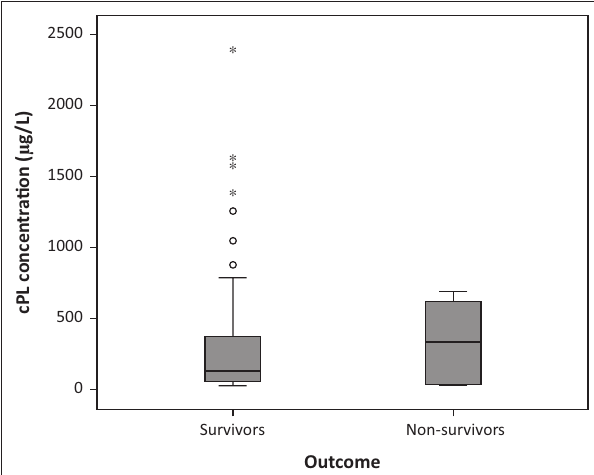
FIGURE 1: A boxplot depicting the canine pancreatic-specific lipase concentration at admission (day 1) in dogs presenting with naturally acquired canine babesiosis and categorised according to